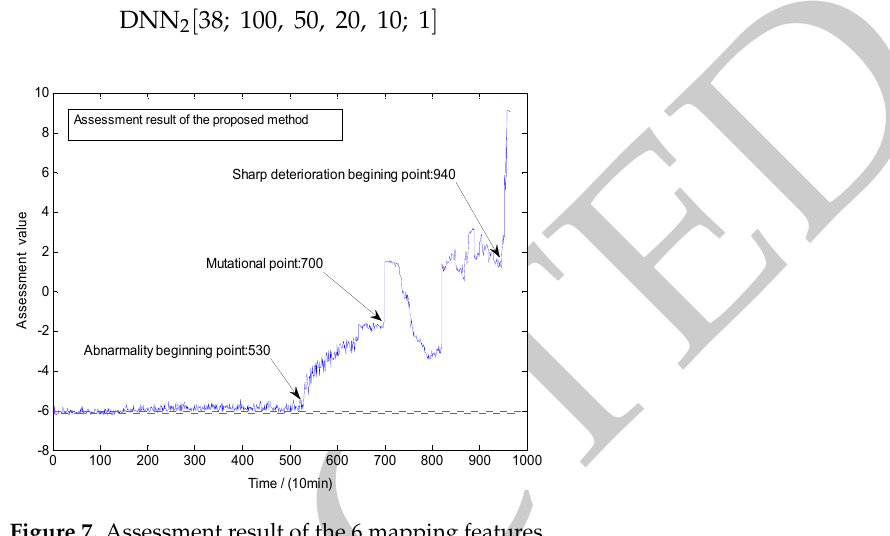
Figure 7. Assessment result of the 6 mapping features.